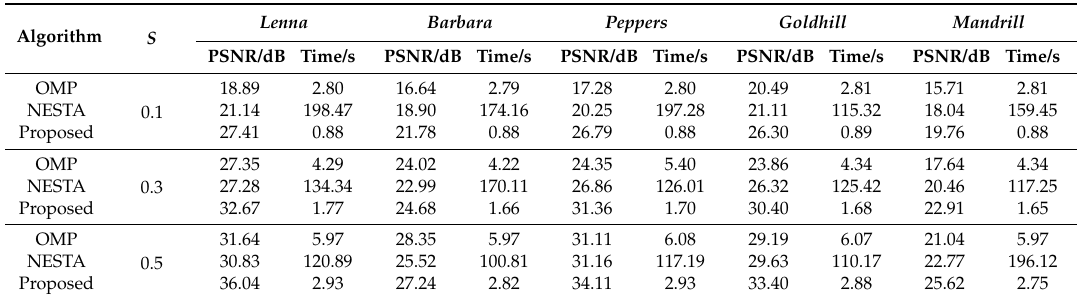
Table 2. Peak Signal-to-Noise Ratio (PSNR) (in dB) and reconstruction time (in s) of different recovery algorithms.